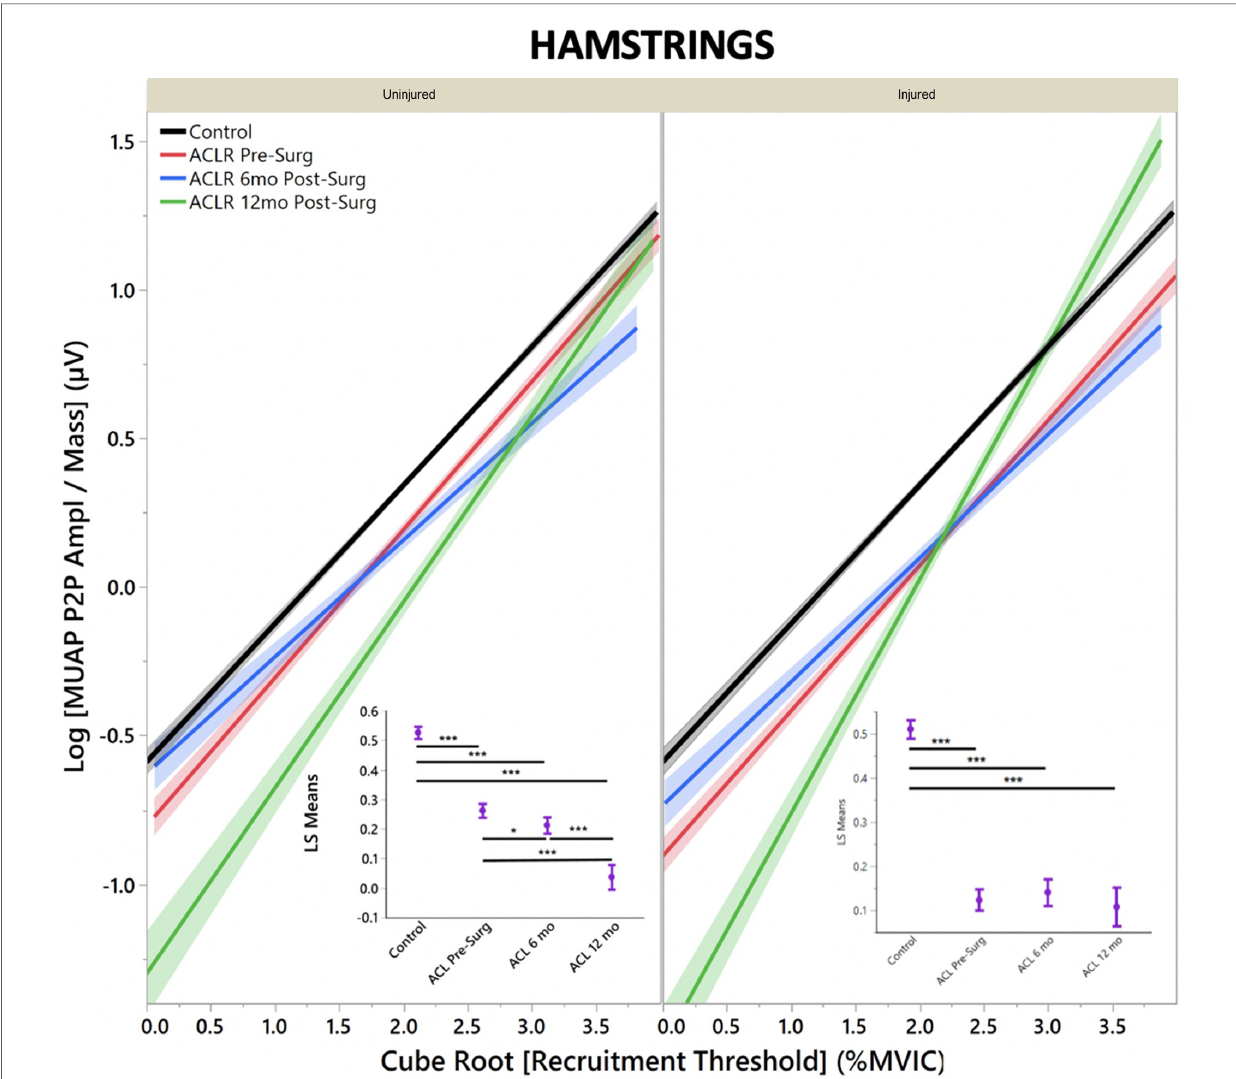
FIGURE 2 Hamstring motor unit action potential by group for uninjured and injured limbs. MUAP Peak to Peak amplitude represents motor unit size. ( Insets ) Least means square ANOVA demonstrates signi fi cant differences of MUAP between groups. (* denotes p <0.05; *** denotes p <0.001; line shading and error bars denote 95% con fi dence intervals of the